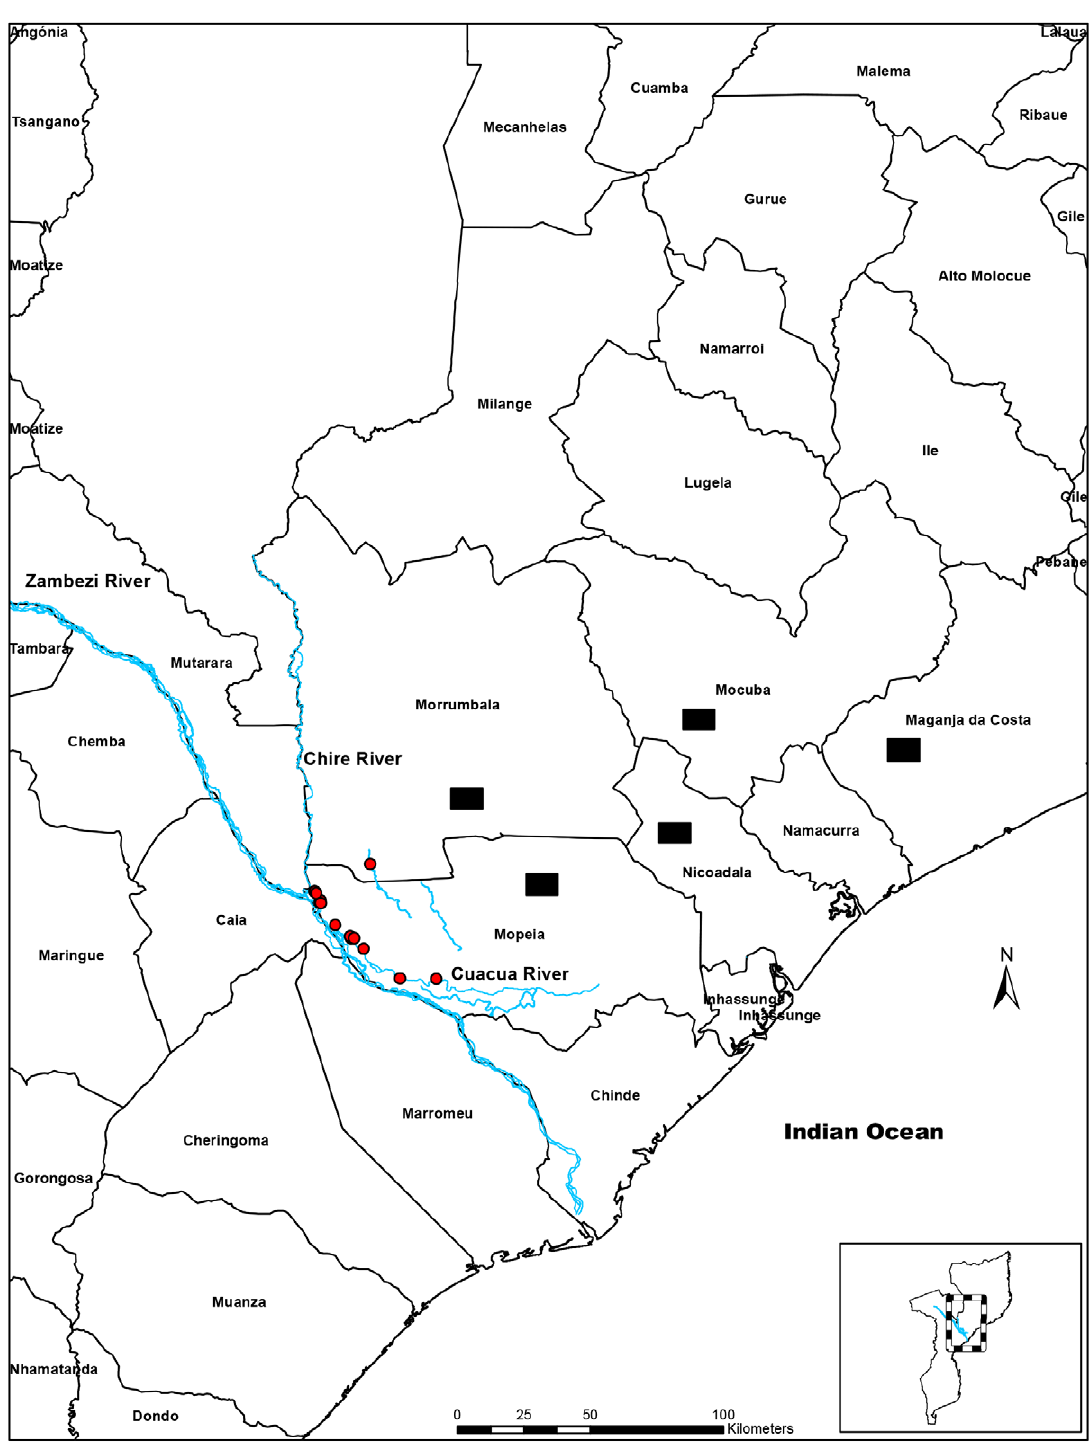
Figure 1. Location of the study areas. Figure 1 shows the map of the Zambe´zia Province, Mozambique indicating the location of the study areas. In 2007, the collection points for the baseline study were in 5 districts namely Maganja da Costa, Mocuba, Mopeia, Morrumbala and Nicoadala (black rectangle). In 2010, the study was carried out in different locations of the Mopeia (red circle) and in Nicoadala districts. Three perennial rivers that drain the Mopeia district namely Zambeze, Cuacua and Chire Rivers are highlighted in